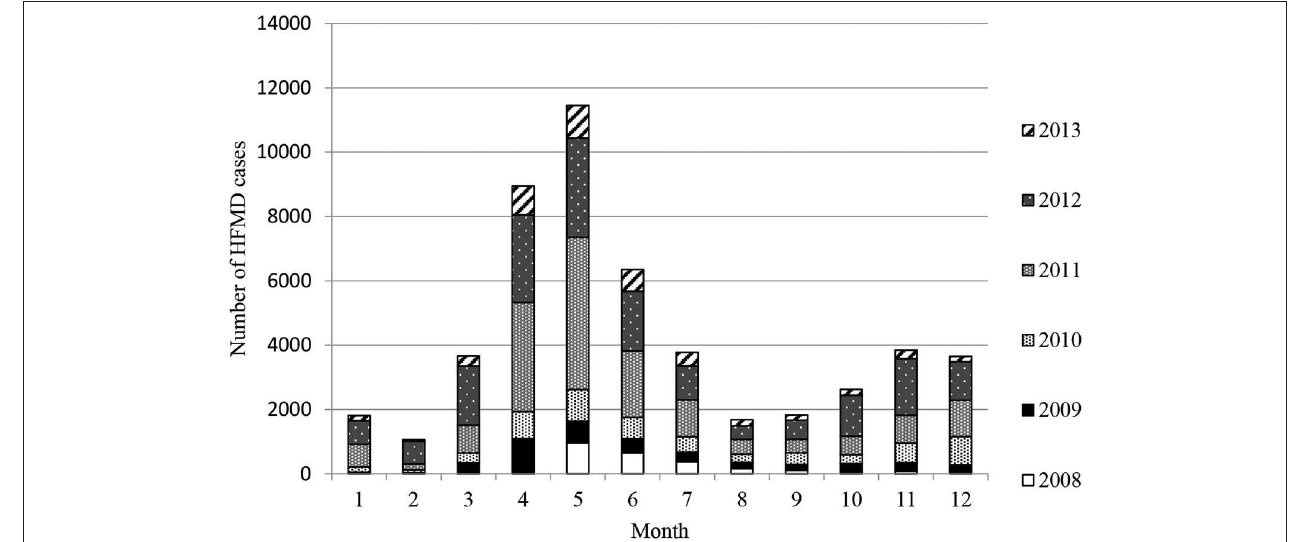
FIGURE 1 | The prevalence of hand, foot, and mouth disease (HFMD) in Xiangyang from 2008 to 2013.